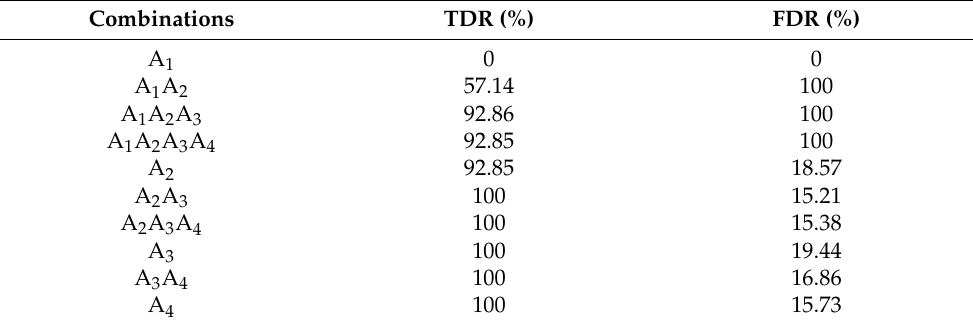
Table 2. Detection results for layer combinations.